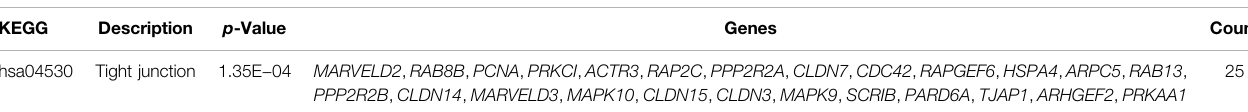
TABLE 1 | KEGG pathway analysis of the three signi fi cant modules genes related to LUAD recurrence.